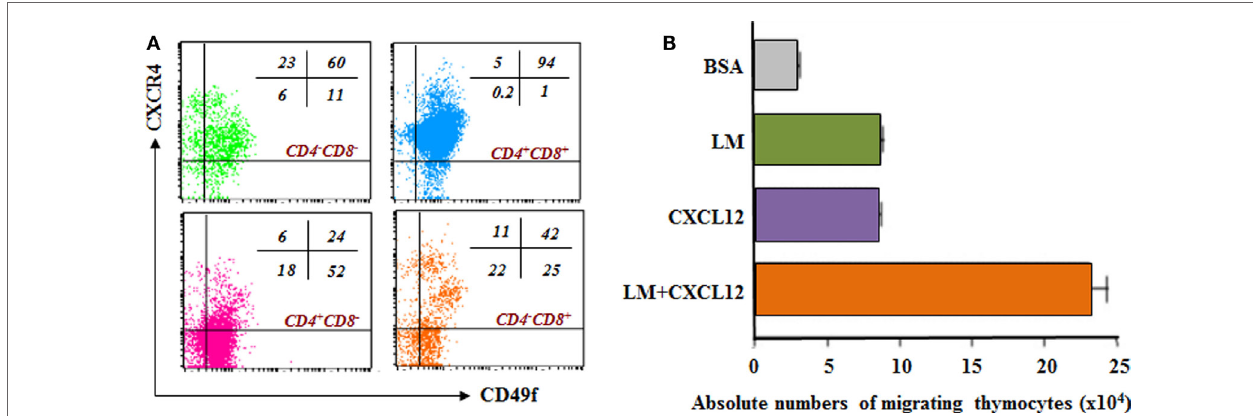
FiGURe 3 | Laminin receptor expression and laminin-driven migration of mouse thymocytes: relationship with CXCL12/CXCR4 interactions . (A) depicts a dot plot derived from four-color cytofluorometric immunostaining of mouse thymocytes. The panel shows the simultaneous membrane expression of CD49f ( α 6 integrin chain) and CXCR4, the CXCL12 chemokine receptor, in the four CD4/CD8-defined thymocyte subsets. In this panel, it is clear that in all immature and thymocyte thymocyte subpopulations, there are cells expressing both receptors. The numbers seen in each dot blot represent the percentages of cells expressing either CD49f and/or CXCR4 in each CD4/CD8-defined thymocyte subset. (B) reveals that thymocytes migrate toward CXCL12 and LM-111, as compared to bovine serum albumin (BSA), used as negative control. Interestingly, when migratory stimuli were applied simultaneously, the resulting migration was higher than the sum of each stimulus used alone, strongly indicating synergy between LM and CXCL12 to stimulate cell migration. Data derived from Ref.